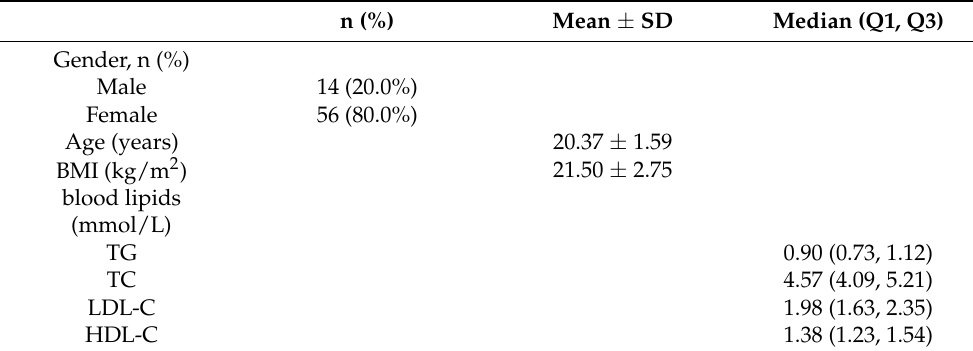
Table 1. Summary of basic characteristics of the 70